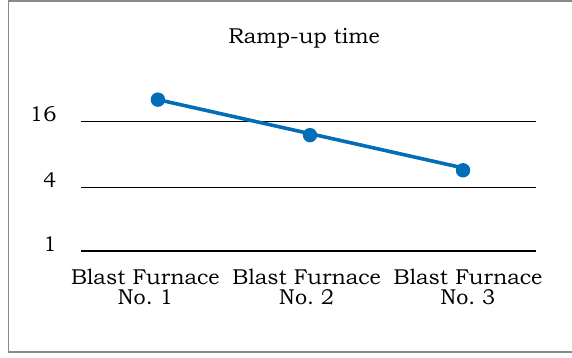
Figure 1. Ramp-up times reduced linearly on a semilog graph